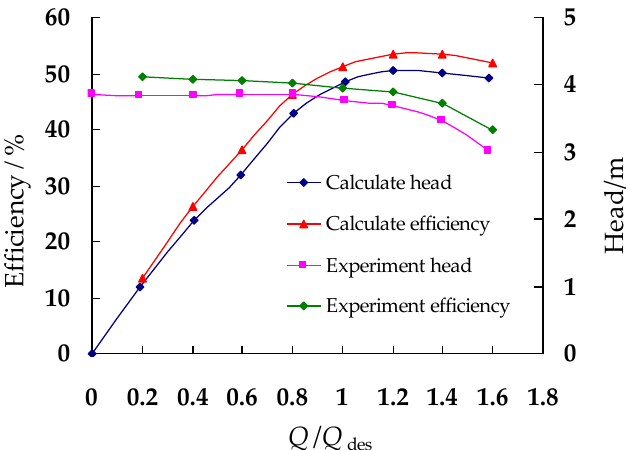
Figure 17. Comparison of pump performance between numerical and experimental results.